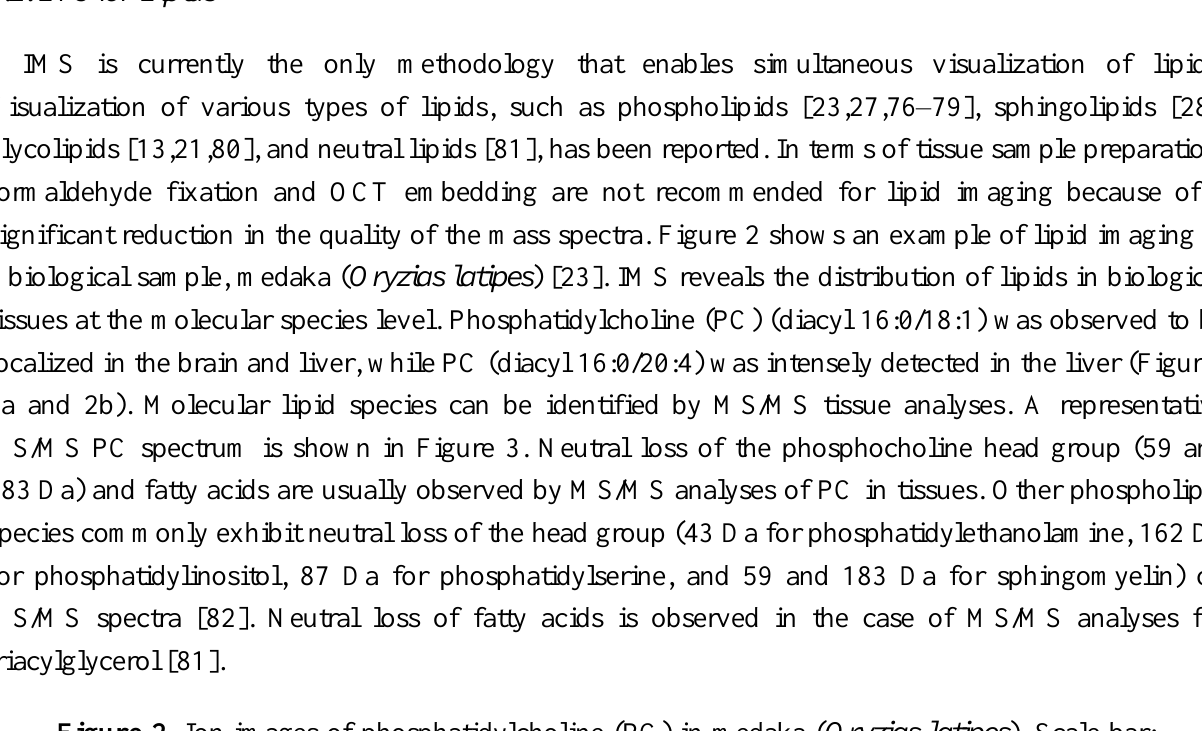
Figure 2. Ion images of phosphatidylcholine (PC) in medaka ( Oryzias latipes ). Scale bar: 2 mm. ( a ) Hematoxylin-eosin staining after MALDI-IMS. ( b ) Distribution of PC (diacyl 16:0/18:1). ( c ) Distribution of PC (diacyl